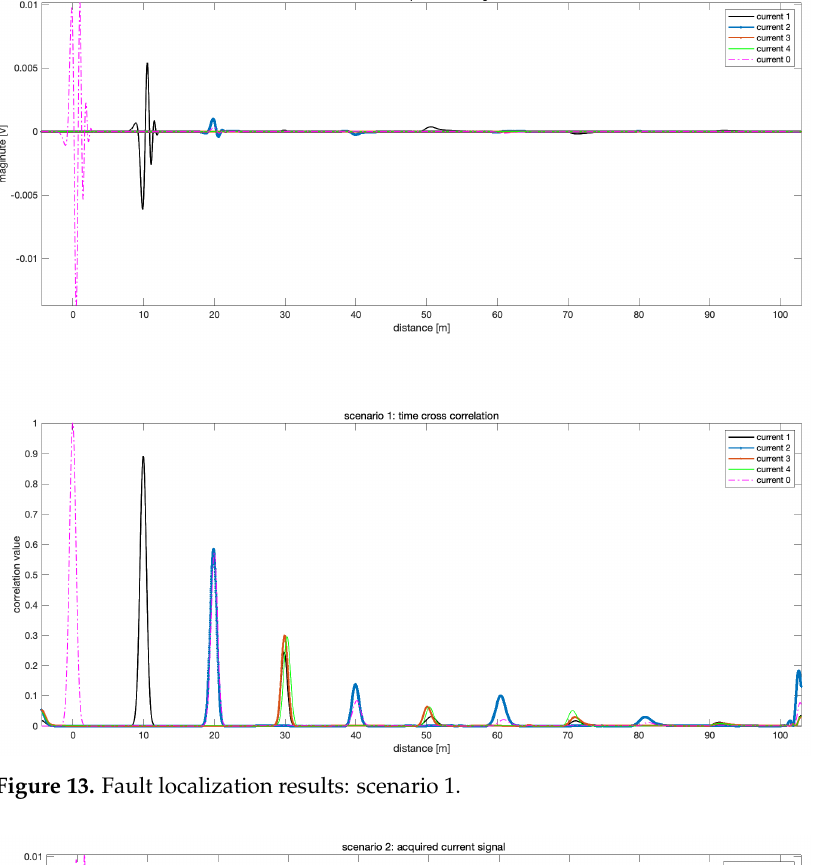
Figure 13. Fault localization results: scenario 1.